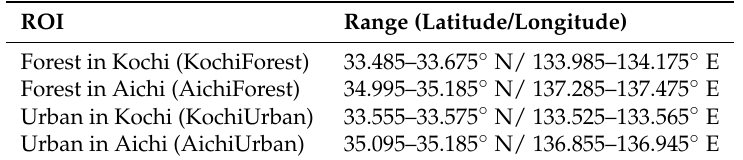
Table 2. Latitude and longitude ranges of the ROIs.